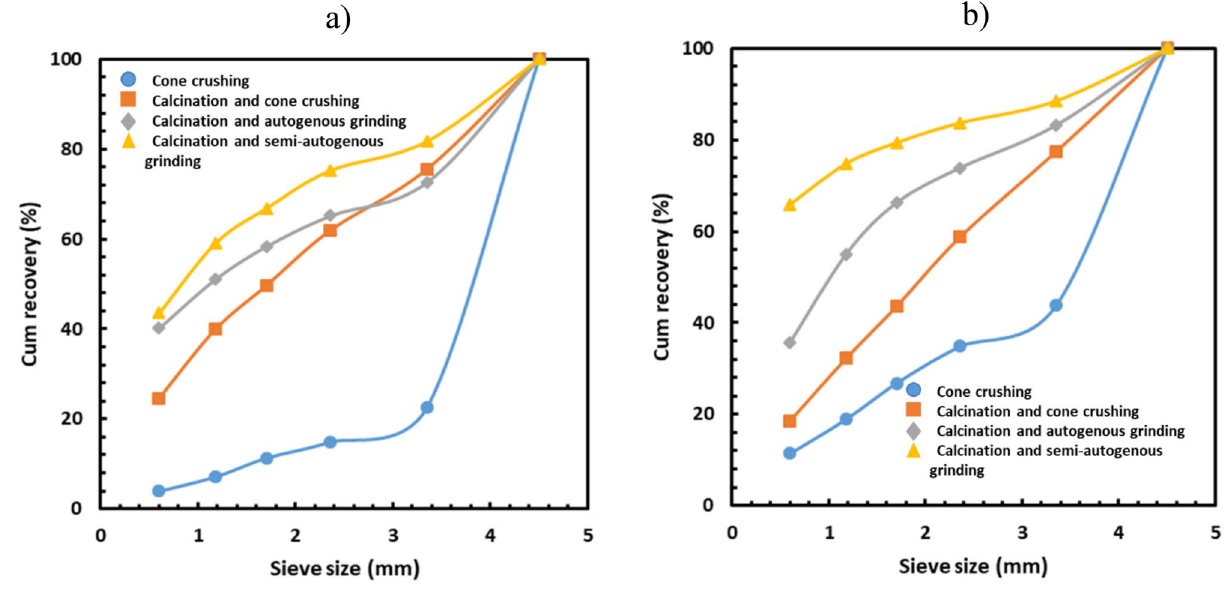
Figure 4. Influence of calcination and comminution methods on cumulative lithium recovery in the case of ( a ) TDMS and ( b ) PF.